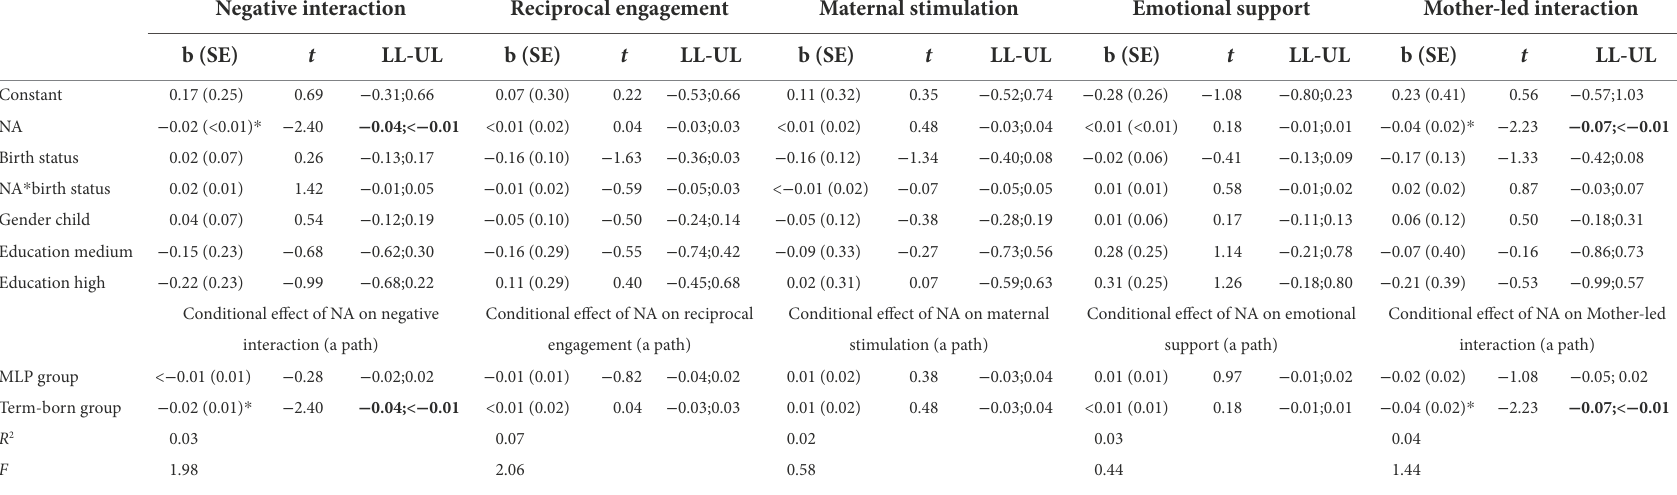
TABLE 4 Mother–child interaction (mediator variables) as outcomes, representing the a paths of the moderated mediation model. Negative interaction Reciprocal engagement Maternal stimulation Emotional